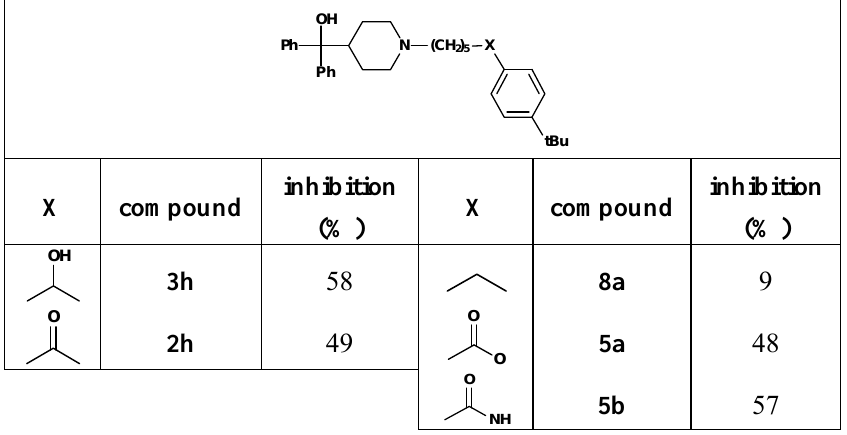
Table 7. Inhibition of protein interaction in AN assay by compounds 5a - 5b , 8a compared to compounds 2h and 3h (R = azacyclonol, concentration: 50 µM, standard deviation ≤ 6 %).